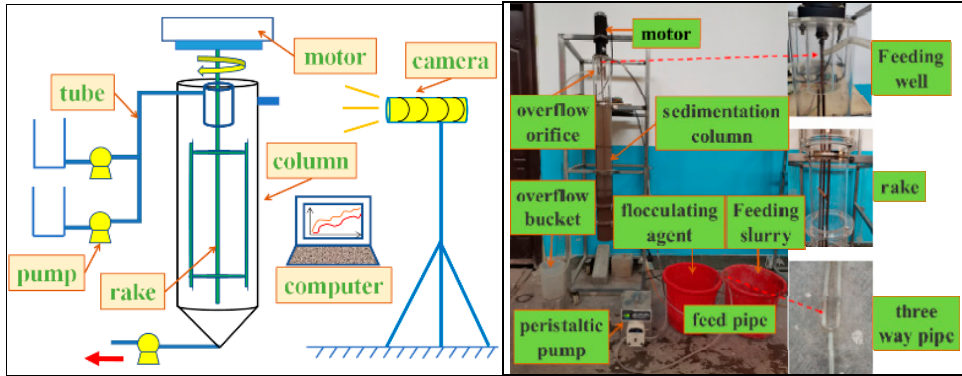
Figure 2. The overall layout of the experimental platform.